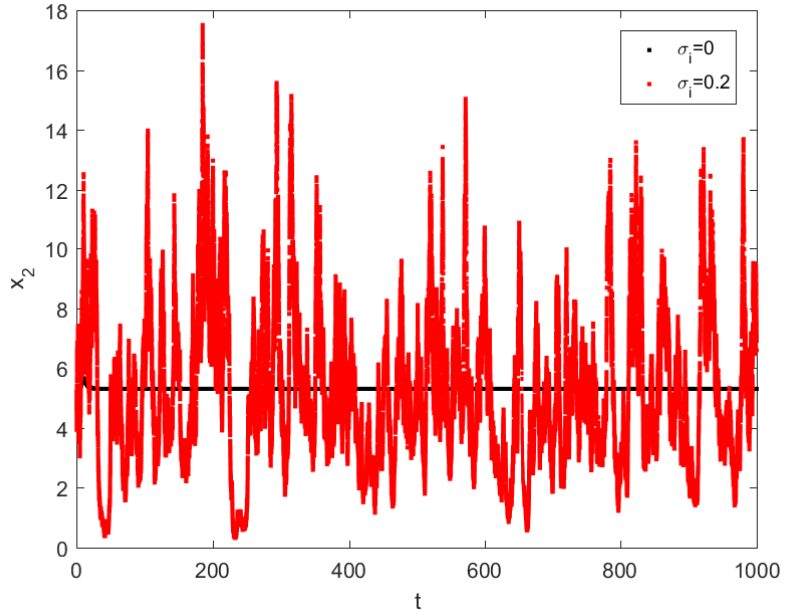
Figure 1. The stochastic Hantavirus system (3) with respect to σ i = 0 and σ i = 0.2.